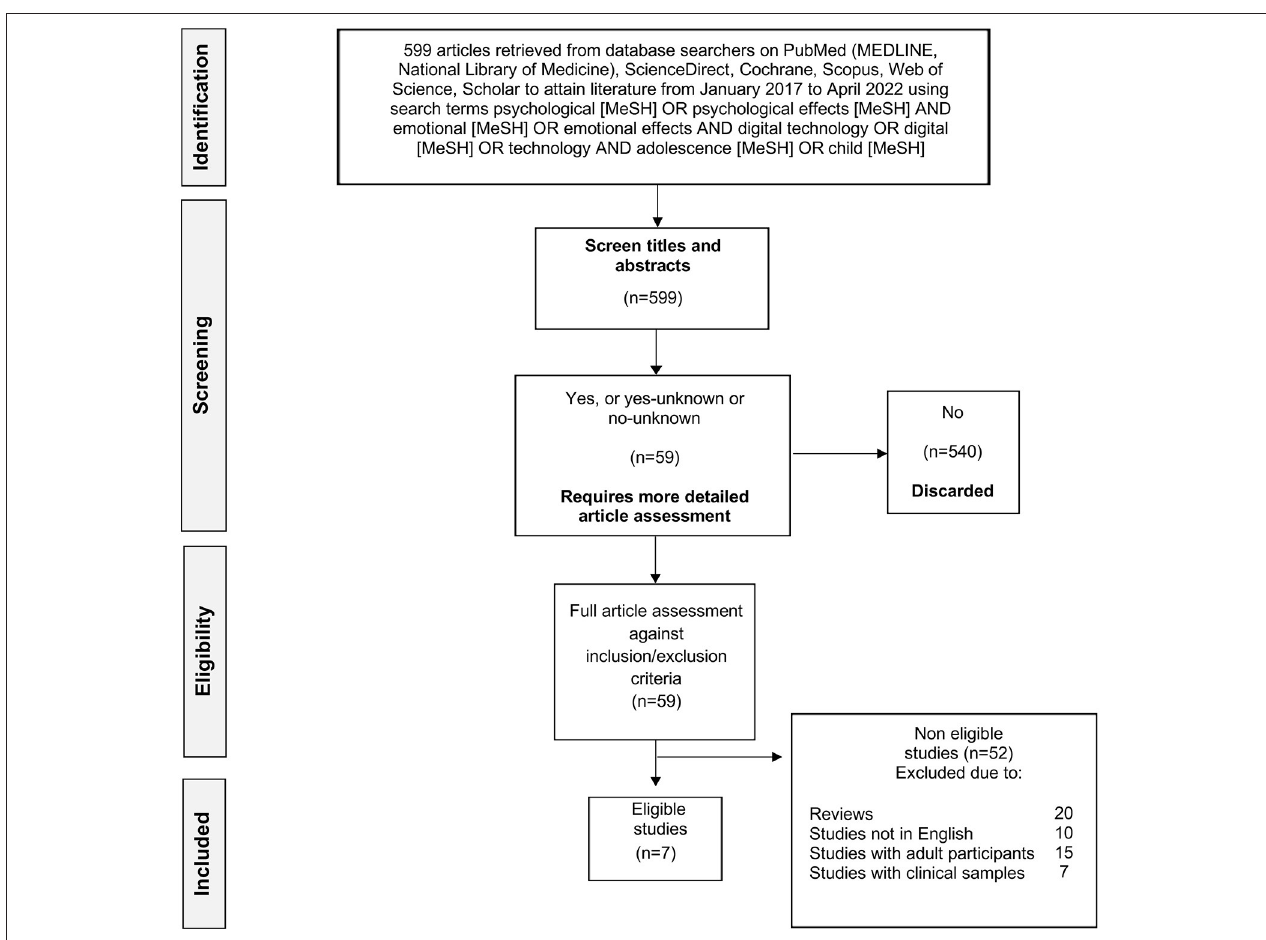
FIGURE 1 | Prisma diagram of the search and selection